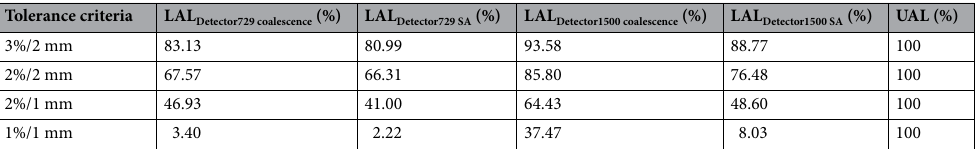
Table 2. Action limits (LAL) of detectors 729 and 1500.